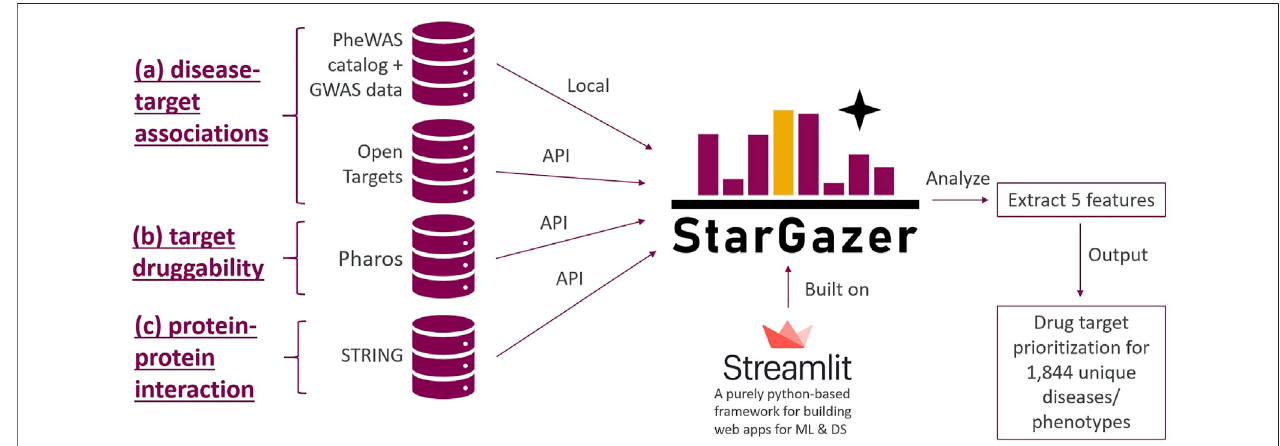
FIGURE 1 | The StarGazer drug target prioritization framework considers the following fi ve features for each of the 1844 diseases in StarGazer ’ s disease list (Xue et al., 2018): — the odds ratios of association between targets and phenotypic variants of interest from GWAS and PheWAS data (Pushpakom et al., 2019); — the target- disease association scores from Open Targets (Li et al., 2016); — the druggability data of genes of interest from Pharos (Shameer et al., 2015); — the degree of nodes in protein-protein interaction networks of genes of interest from STRING; and (Lee and Bhakta, 2021) — the presence of the gene variant of interest in both PheWAS and GWAS datasets. All data, except the PheWAS and GWAS data, are loaded in real-time by API calls and therefore present the latest evidence for drug repositioning strategies. The above fi ve features are then integrated to provide a singular numerical StarGazer score which quanti fi es the drug repositioning potential of a gene. StarGazer is built on the Python-based Streamlit platform, which is largely used for building sleek and modern web applications for machine-learning and data